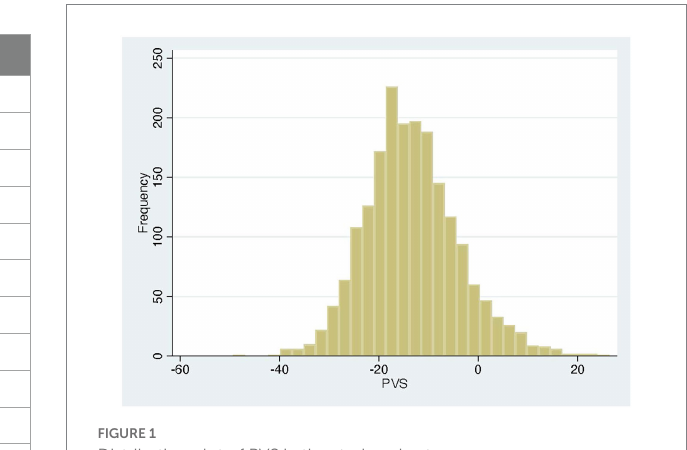
FIGURE 1 Distribution plot of PVS in the study cohort.